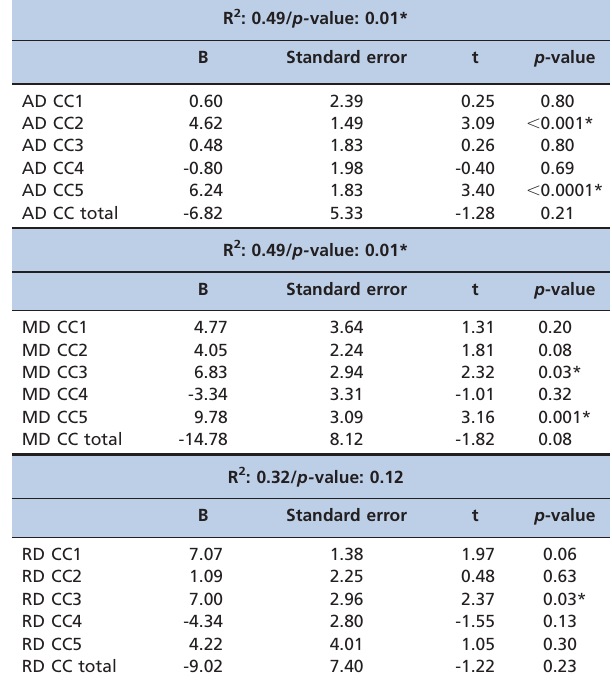
Table 4 - Multiple regression analysis using the Expanded Disability Status Scale as a dependent variable and diffusion tensor imaging indices as independent